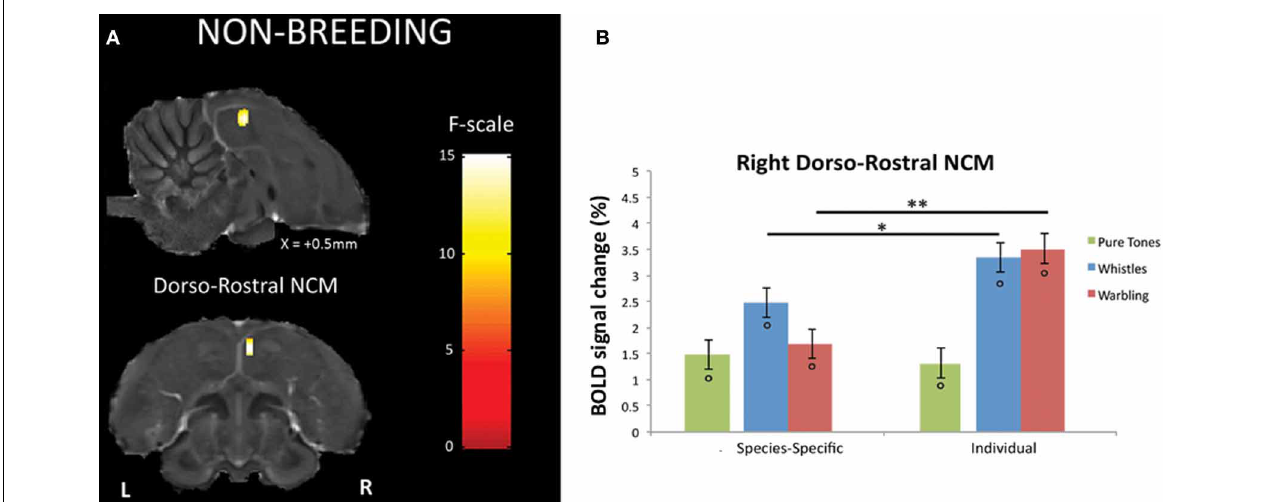
FIGURE 4 | Neural substrates for differential song processing during the non-breeding season. (A) Superimposition of the statistical results to anatomical sagittal and axial images coming from the high-resolution starling image. The position of the slice along the X (left/right) axis is indicated (the + sign indicates that results are from the right hemisphere). Results are of those voxels displaying a significant differential response between songs conveying species-specific and group information (SPEC) and songs conveying individual information (INDIV). F -values are color coded according to the scale displayed on